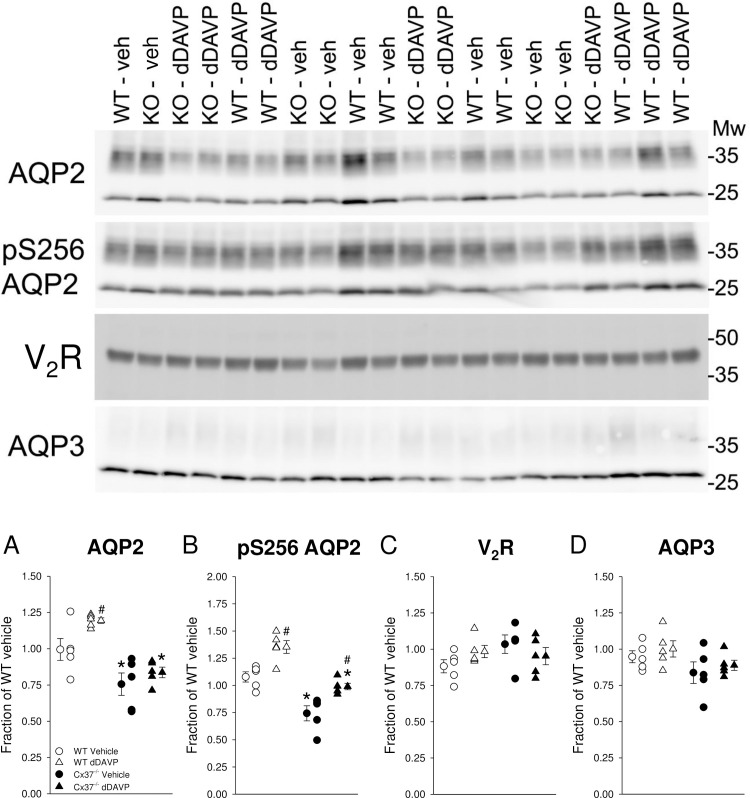
Renal abundance and phosphorylation of AQP2 is reduced under vehicle and impaired in Cx37-/- compared to WT mice in response to V2R activation.Sixty minutes after vehicle application Cx37-/- mice had lower abundance of (A) total and (B) phosphorylated serine 256 AQP2 compared with WT mice. Systemic administration of dDAVP following suppression of endogenous arginine-vasopressin overnight (see Materials and methods for details) increased the abundance of (A) total and (B) phosphorylated serine 256 AQP2 in both genotypes; however, the effect was attenuated in Cx37-/- mice. No differences in the abundance of V2R or AQP3 were observed between genotypes or treatments. Data are expressed as mean ± SEM; n = 5 each genotype and condition. Data were analyzed by paired and unpaired Student’s t-test, *P<0.05 versus WT same condition, #P<0.05 versus vehicle same genotype.